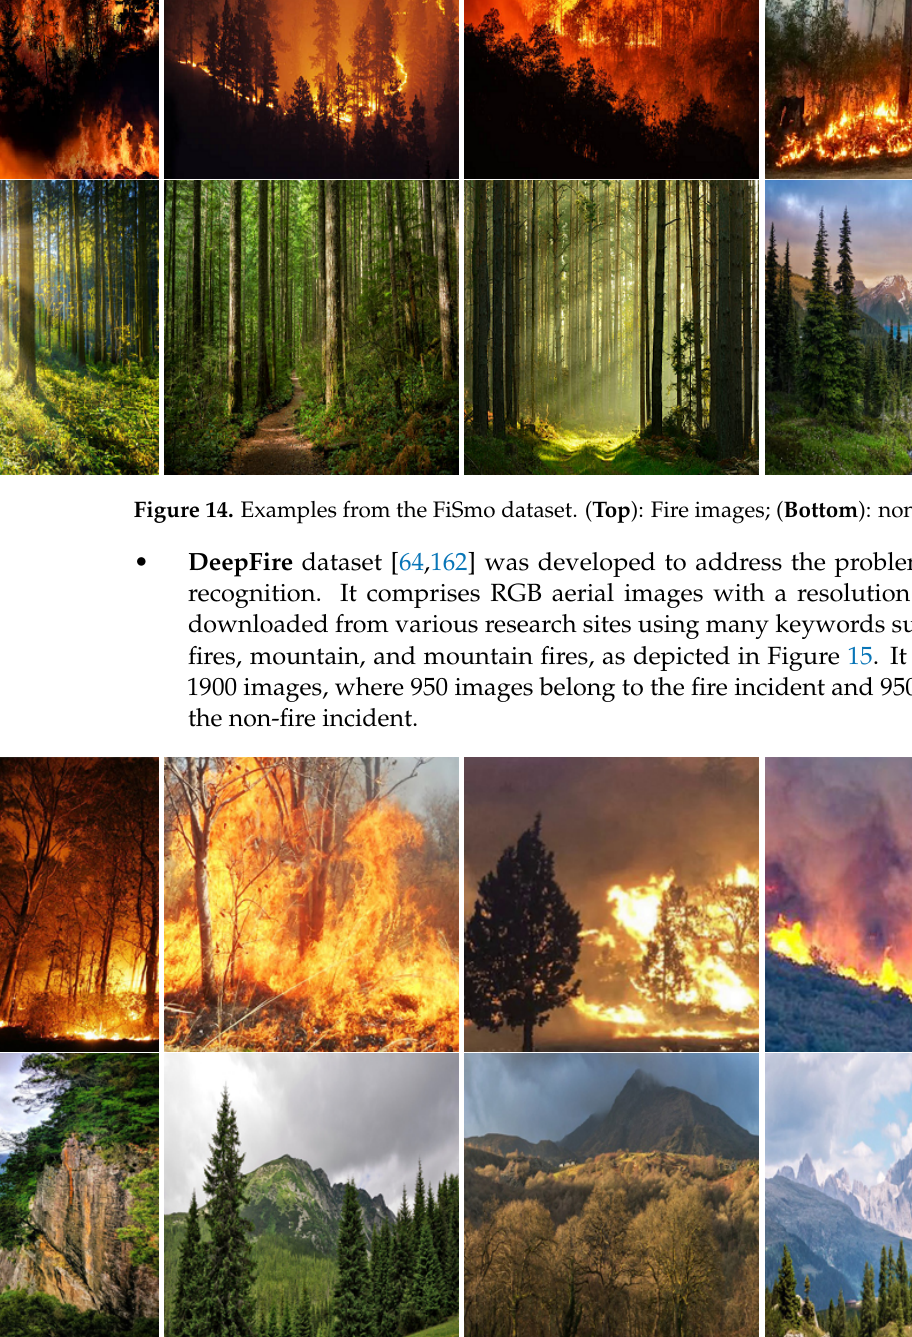
Figure 15. DeepFire dataset example. ( Top ): Fire images; (Bottom ): non-fire